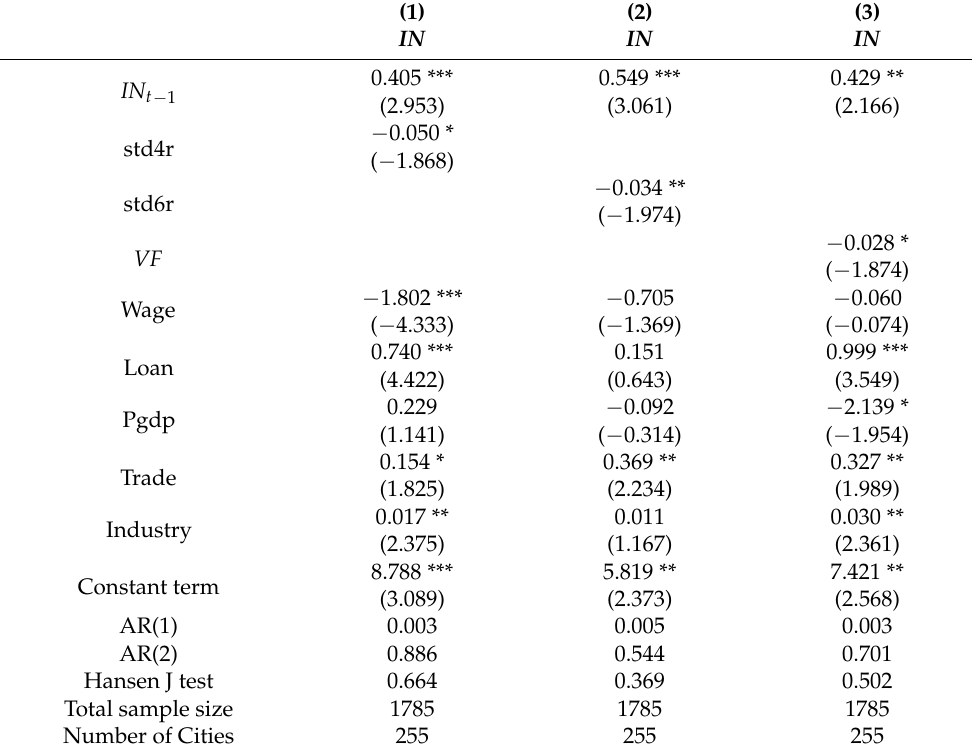
Table 3. Robustness